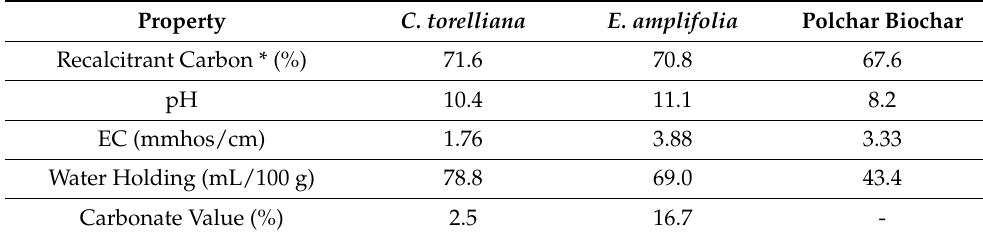
Table 4. Properties of biochar made from Florida C. torelliana and E. amplifolia trees with Polchar biochar (adapted from